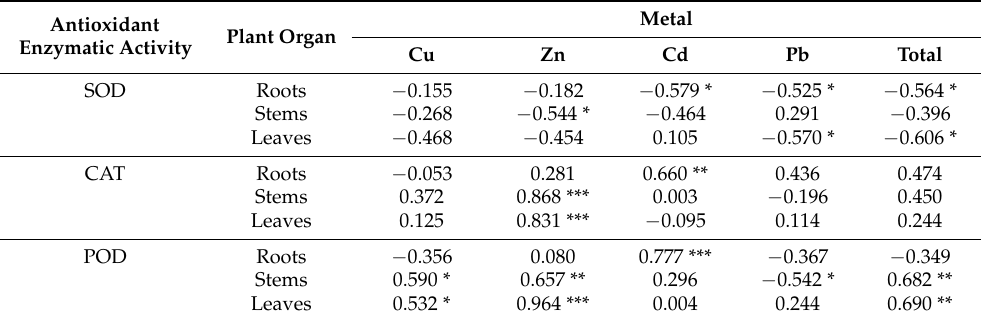
Table 5. Pearson correlations between antioxidant enzyme activities of superoxide dismutase (SOD), catalase (CAT), and peroxidase (POD) and metal concentration in different organs of S. perfoliatum plants.